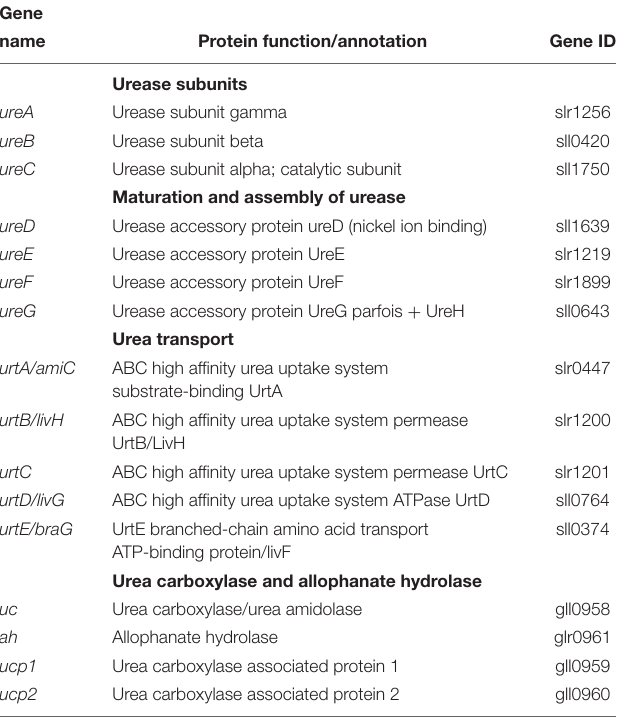
TABLE 1 | Reference of the Synechocystis PCC 6803 (sll or slr) or Gloeobacter violaceus PCC 7421 (gll or glr) genes (from CyanoBase https://www.ncbi.nlm.nih.gov/protein) used to identify genes operating in urea acquisition and catabolism in other